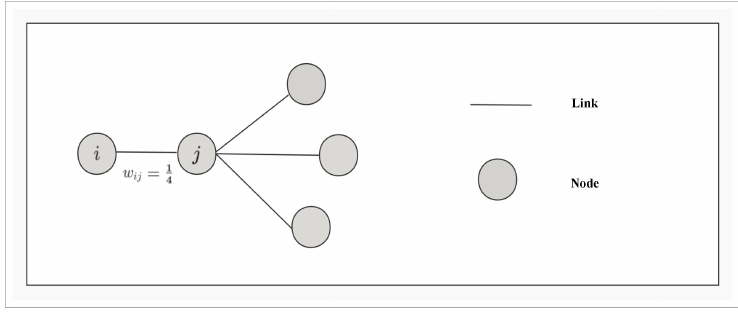
Figure 2. The setting of side weights in the road monitoring